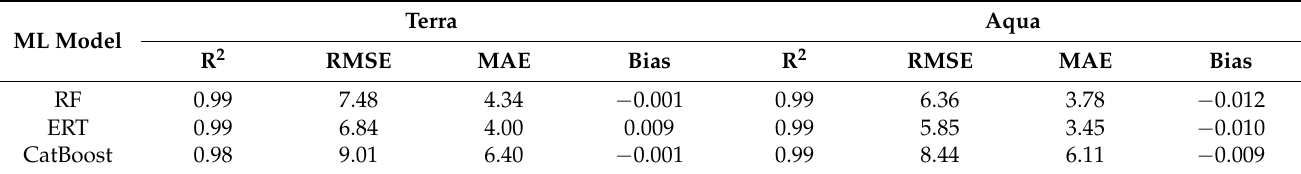
Table 3. Comparison of the training accuracy of the three ML algorithms using both Terra and Aqua samples. Different from other metrics, we retained three significant digits after the decimal point for the bias because the values are too small. The units of the RMSE, MAE, and bias metrics are W/m 2 . Terra Aqua ML Model R 2 RMSE